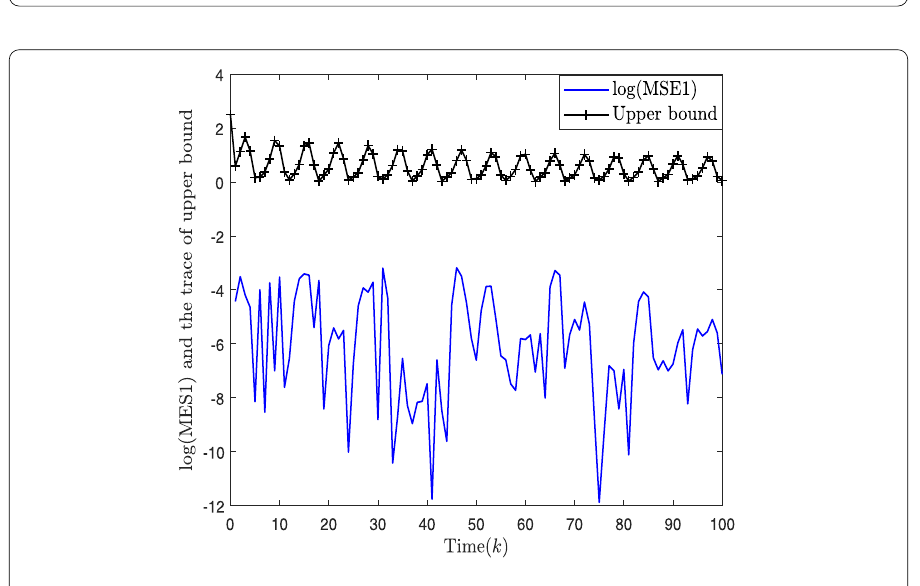
Figure 4 log(MSE1) and its upper bound